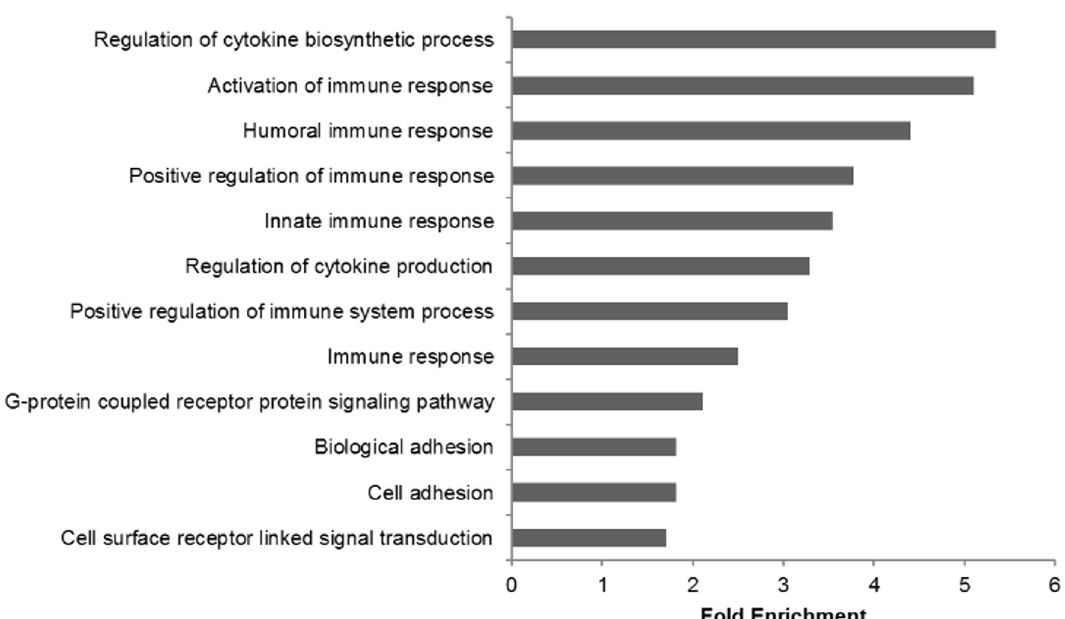
Fig 1. Differential gene expression between treated and control P . helianthoides . Fold change (Log 2 ) expression between treated and control organisms is plotted where positive values represent contigs expressed at higher level in treated sea stars. Red circles indicate those contigs determined to be differentially expressed (padj < .05; n = 3773). Differential expression of contigs was calculated using a negative binomial GLM in the R package DESeq2.